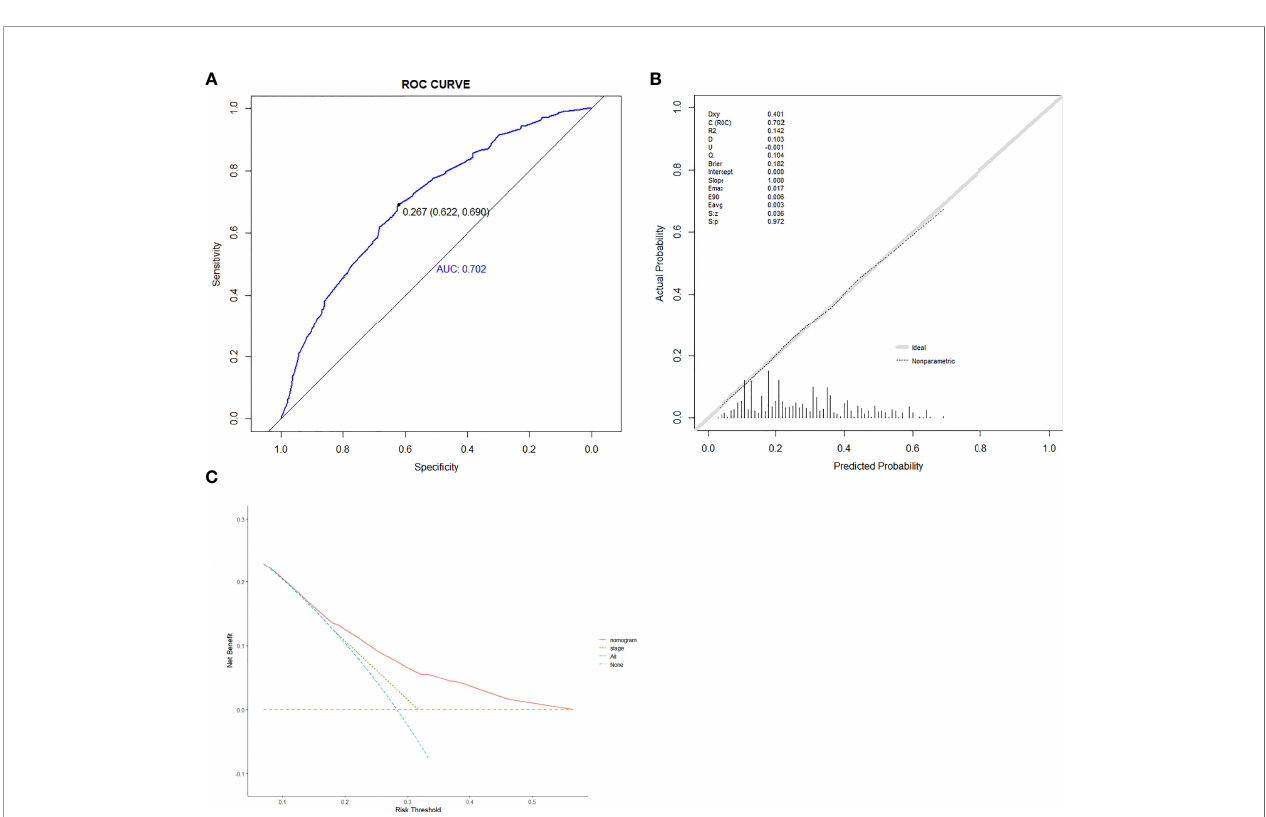
FIGURE 3 | The receiver operating characteristic curve (A) , calibration curve (B) , and decision curve analysis (C) of the diagnostic nomogram in training